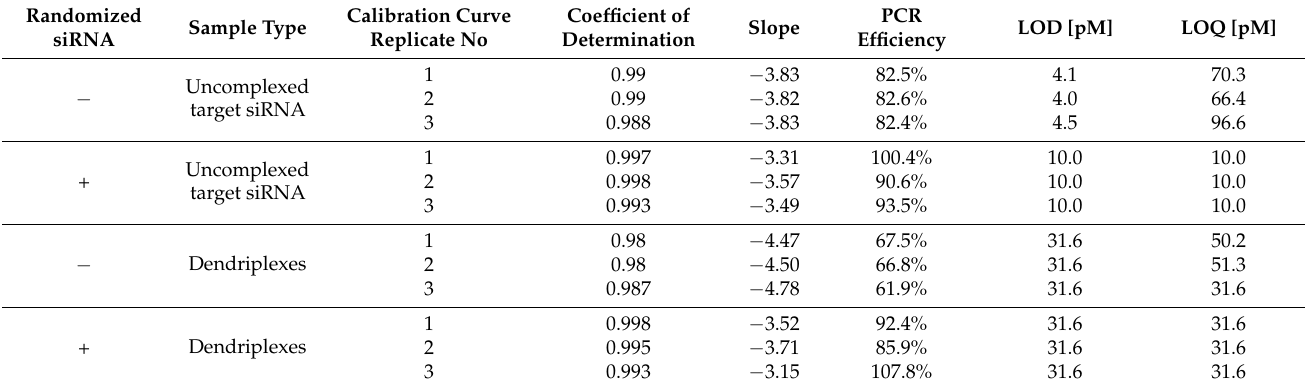
Table 1. Statistical parameters, indicating intra- and inter-assay reproducibility and linearity of the assay under varying conditions. The threshold for determination of C t values was kept constant at 0.03 RFU in all experiments. All dilution series were performed three times in separate experiments (biological triplicates), each with technical triplicates. Limit of detection and limit of quantification were defined as LOD = 3.3 × (standard deviation of linear regression/slope of the regression line) and LOQ = 10 × (standard deviation of linear regression/slope of the regression line) [48,49]. In case of NTC threshold line crossing, LOQ (and LOD) was calculated according to Wolfinger et al. [50]. Additionally, lowest experimentally measured concentrations were defined as minimum possible values for LOD and